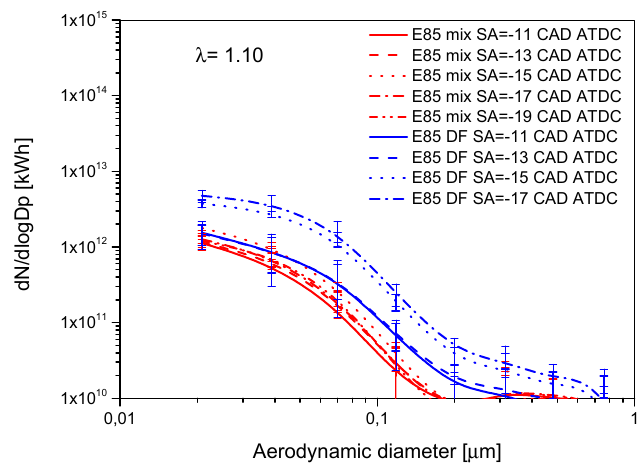
Figure 16. Particle size distribution for λ = 1.1.